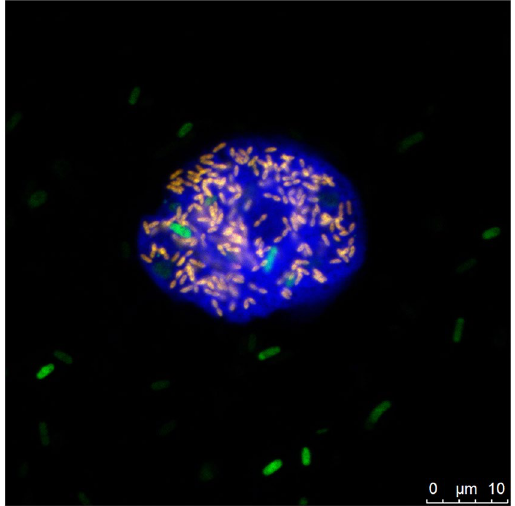
Figure 2. Identification of ‘ Candidatus Cochliophilus cryoturris’ PDD8 in its native host Cochliopodium minus by fluorescence in situ hybridization. The bacterial endosymbionts were visualized with the specific probe PDD8-644 labeled with Cy3 (red) and general bacterial probes (EUB-mix) labeled with Fluos (green; the overlap appears yellow). E. coli cells added as amoeba food source are visible in green; the Cochliopodium minus trophozoite was counterstained using the eukaryotic probe EUK516 labeled with Cy5 (blue).